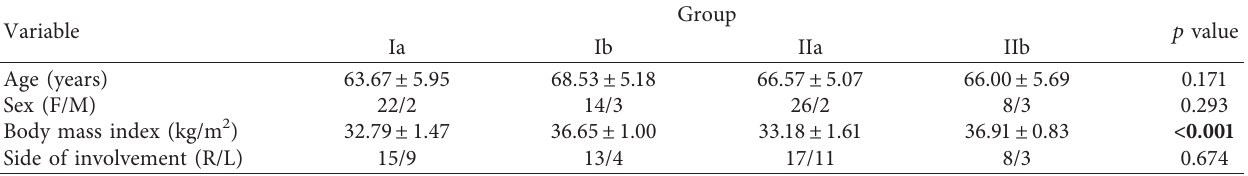
Table 1: A comparative overview of demographic variables under investigation.